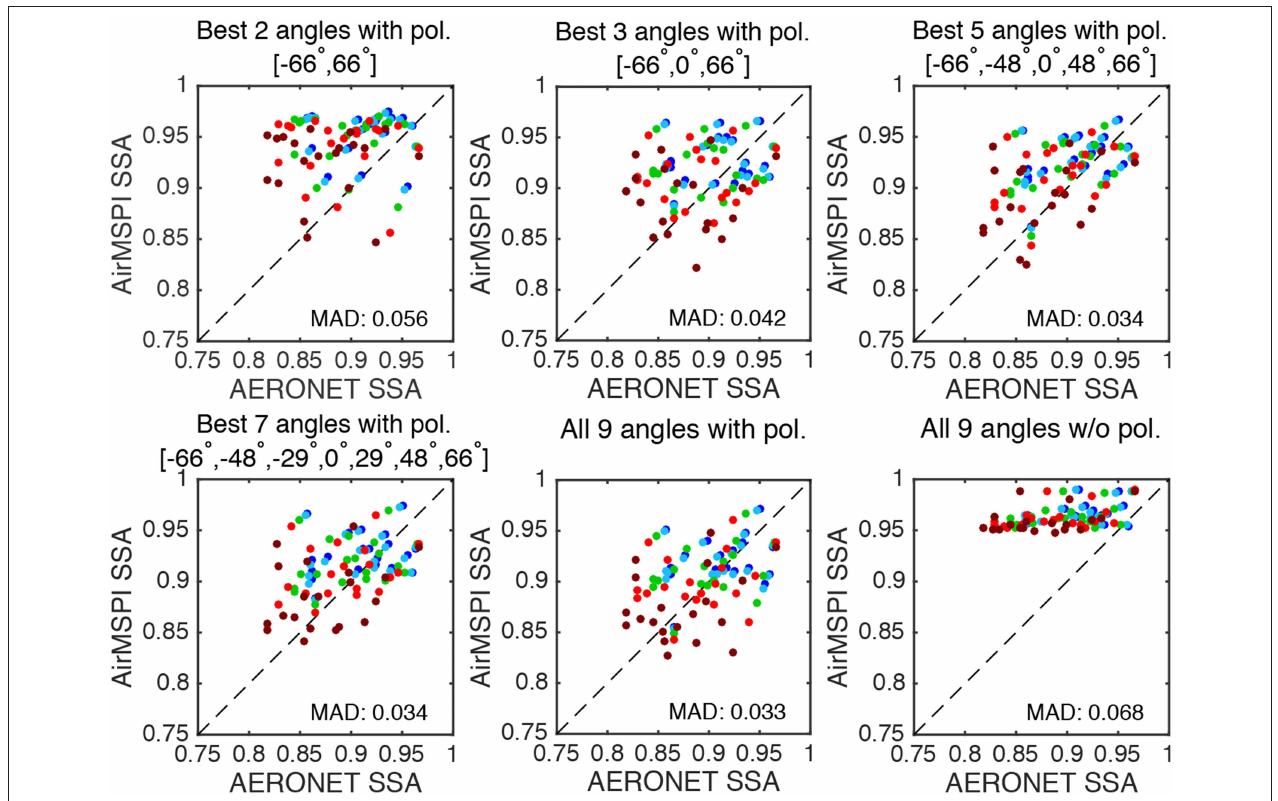
FIGURE 8 | Scatter plots of AirMSPI-retrieved SSA against collocated AERONET values using a different number of viewing angles and polarization features. The results of SSA are plotted in different colors for five wavelengths from visible to near-infrared: dark blue (445nm), light blue (470nm), green (555nm), red (660nm), and brown (865nm). The mean absolute difference (MAD) between the two retrievals is listed in the bottom right of each subplot. “Best angles” are identified as the subset of AirMSPI viewing angles that gives the best agreement with AERONET derived values. Reprinted with permission from Xu F. et al. (2017), John Wiley & Sons.